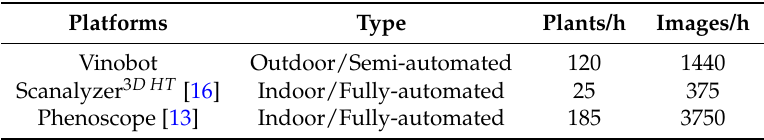
Table 4. Comparison between field-based systems that perform detailed phenotyping of individual